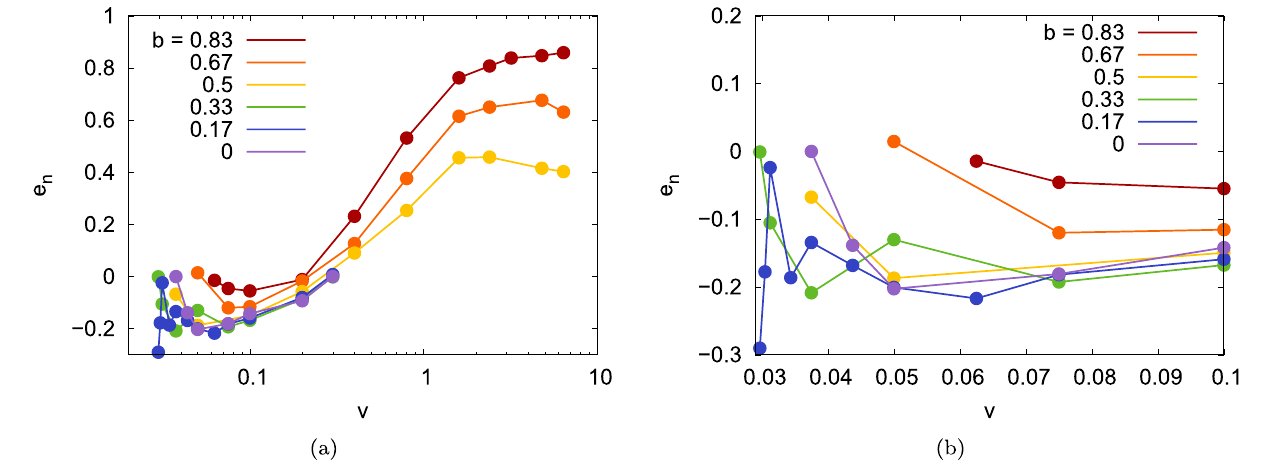
Figure 4. ( a ) Normal restitution coefficient, e n , as a function of collision velocity v for several impact parameters b . ( b ) zooms into the low-velocity region. Data are only shown for bouncing collision. Note the logarithmic abscissa scale in subpanel ( a ).